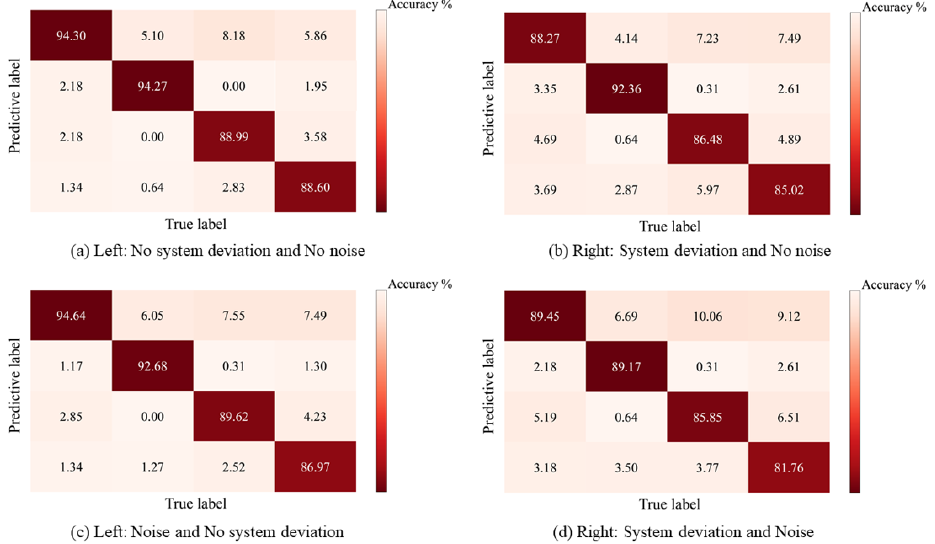
Figure 9. Confusion matrix of blade crack location detection results.